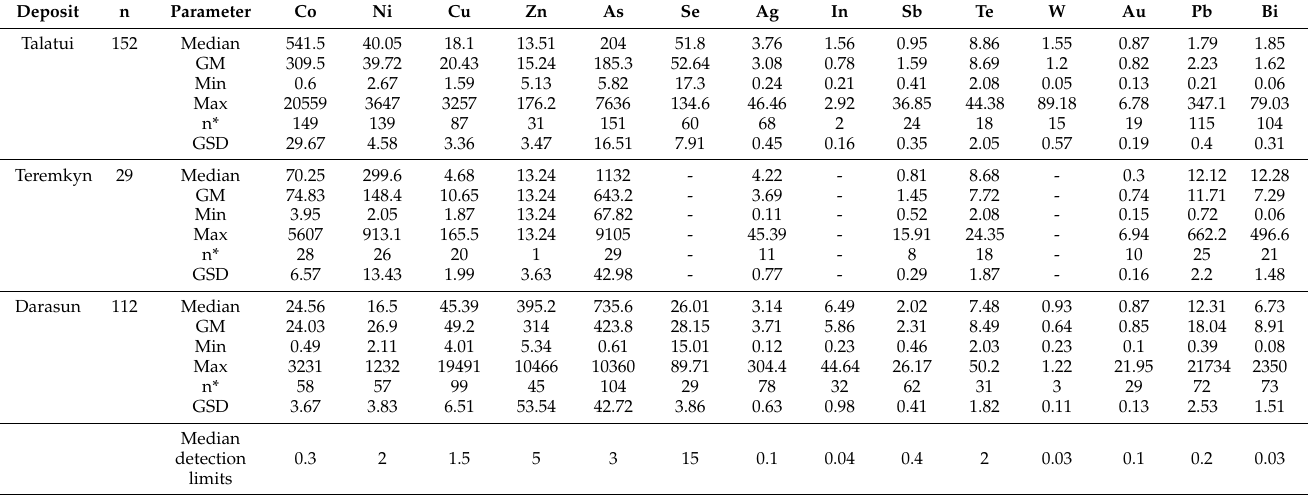
Table 2. Compilation of LA-ICP-MS analyses (ppm) for trace element of pyrite from Talatui, Teremkyn, and Darasun deposits.